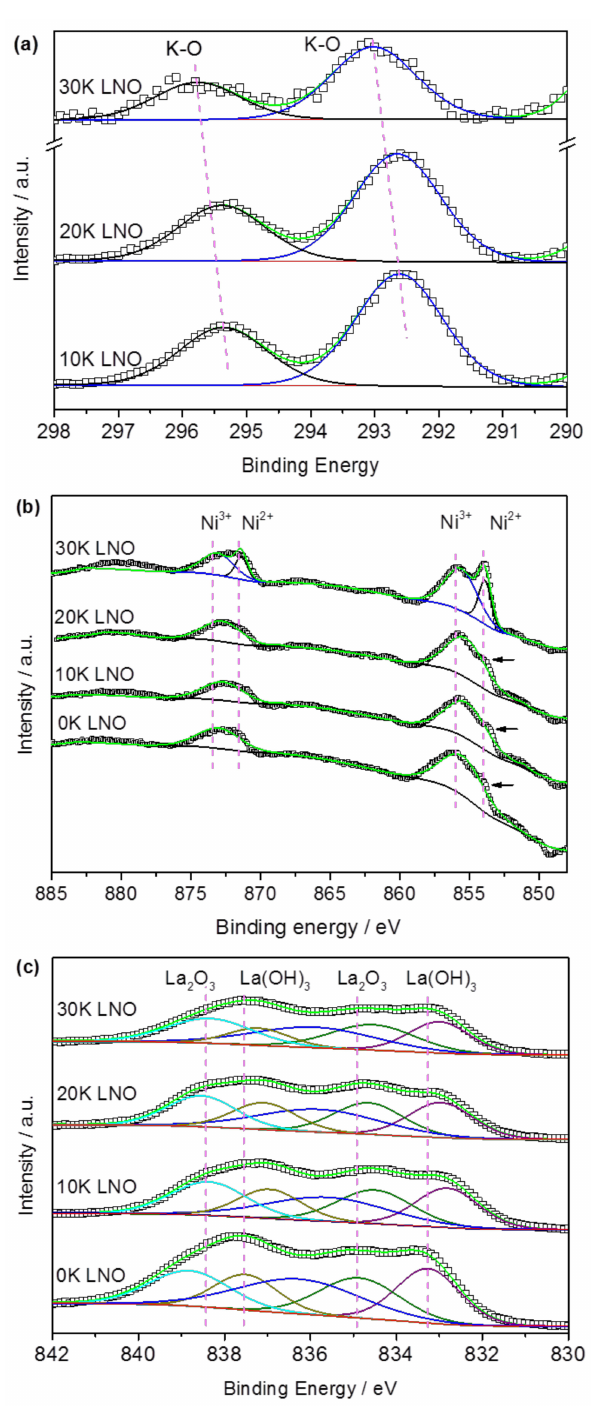
Figure 4. XPS profiles of ( a ) K 2p, ( b ) Ni 2p, and ( c ) La 3d of 0–30 K LNO